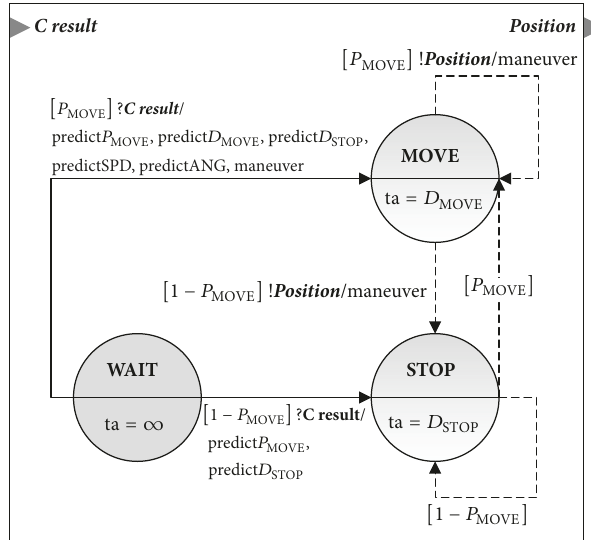
Figure 8: Mobility model design using the DEVS formalism.